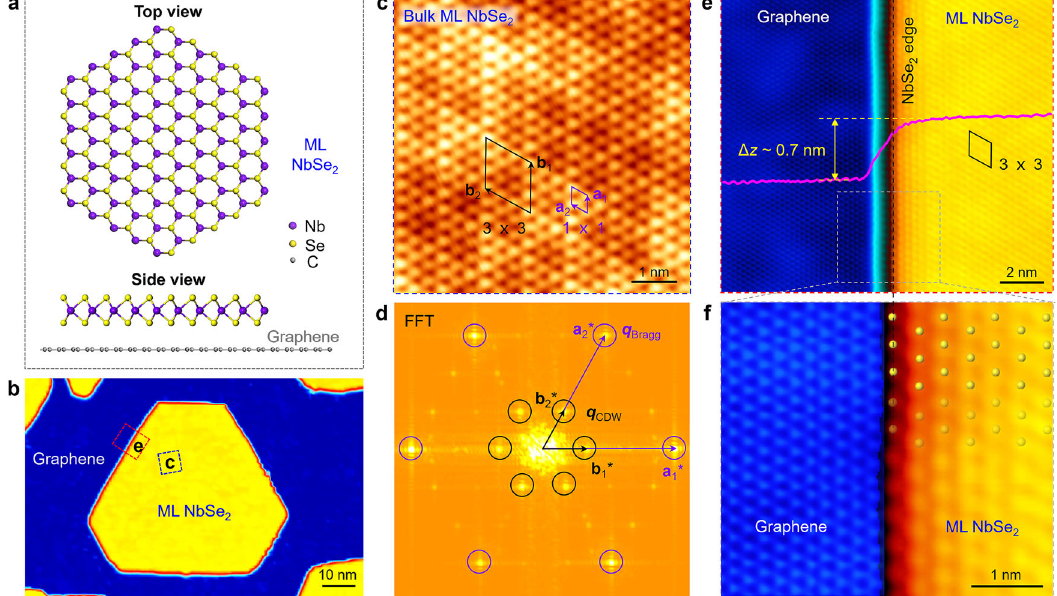
Fig. 1 Edge structures of monolayer (ML) NbSe 2 . a Side and top views of the atomic structures of ML NbSe 2 on graphene. Nb, Se, and C atoms are displayed by purple, yellow, and gray spheres, respectively. b Large-scale scanning tunneling microscopy (STM) image of a high-quality ML NbSe 2 island on bilayer graphene (BLG)/SiC(0001) (sample bias: − 1 V, tunneling current: 5 pA). c Atomic-resolution STM image of the bulk ML NbSe 2 , as marked by the dashed blue square in panel b (sample bias: − 0.1 V, tunneling current: 1 nA). The top Se atoms dominate the STM image, exhibiting a commensurate 3 × 3 charge-density-wave (CDW) superlattice. a 1 /a 2 and b 1 /b 2 denote the basis vectors of atomic lattice and CDW superlattice, respectively. d Fast Fourier transform (FFT) of the topographic STM image shown in panel c. The outer six purple circles indicate the Bragg lattices of NbSe 2 , and the inner six black circles are related to the CDW orders in NbSe 2 with q CDW ≈ q Bragg /3. a 1 * /a 2 * and b 1 * /b 2 * denote the reciprocal basis vectors of atomic lattice and CDW superlattice, respectively. e Atomic-resolution STM image at the edge of ML NbSe 2 island (sample bias: − 0.1 V, tunneling current: 1 nA). The height pro fi le across the edge shows the apparent height Δ z of the island is about 0.7 nm, indicating the NbSe 2 is one-layer thickness. f Zoomed-in STM image of the dashed gray rectangle in panel e (sample bias: − 0.1 V, tunneling current: 1 nA). The atomic structures of the top Se atoms are superposed on the image, demonstrating that the edge of ML NbSe 2 exhibits a well-ordered zigzag con fi